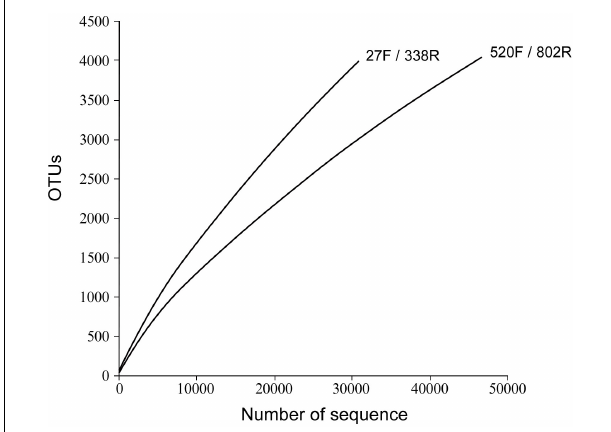
TABLE 4 | Taxonomic binning of amplicons from precipitant sampled throughout the nuclear fuel storage basin.